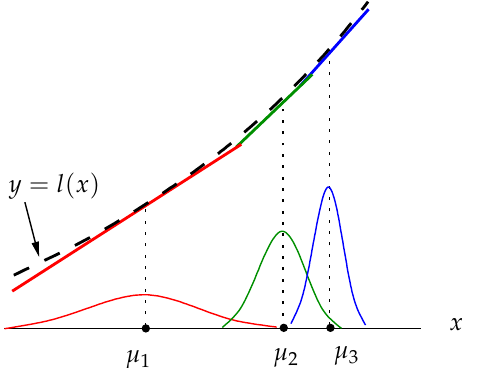
Figure 4. Piece-wise linear approximation of the almost linear relationship y = l ( x ) around the GMM centers. Approximation accuracy is greater where PDF ( x ) is large.